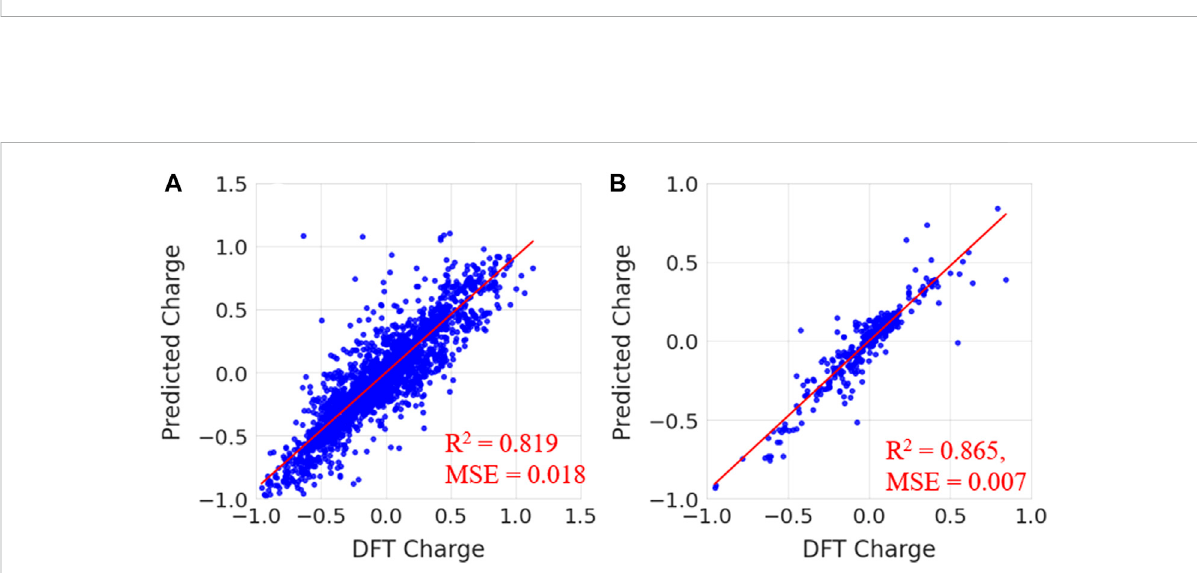
FIGURE. 8 A few small molecules were selected from test set-2 for the validation of the random forest regression model.